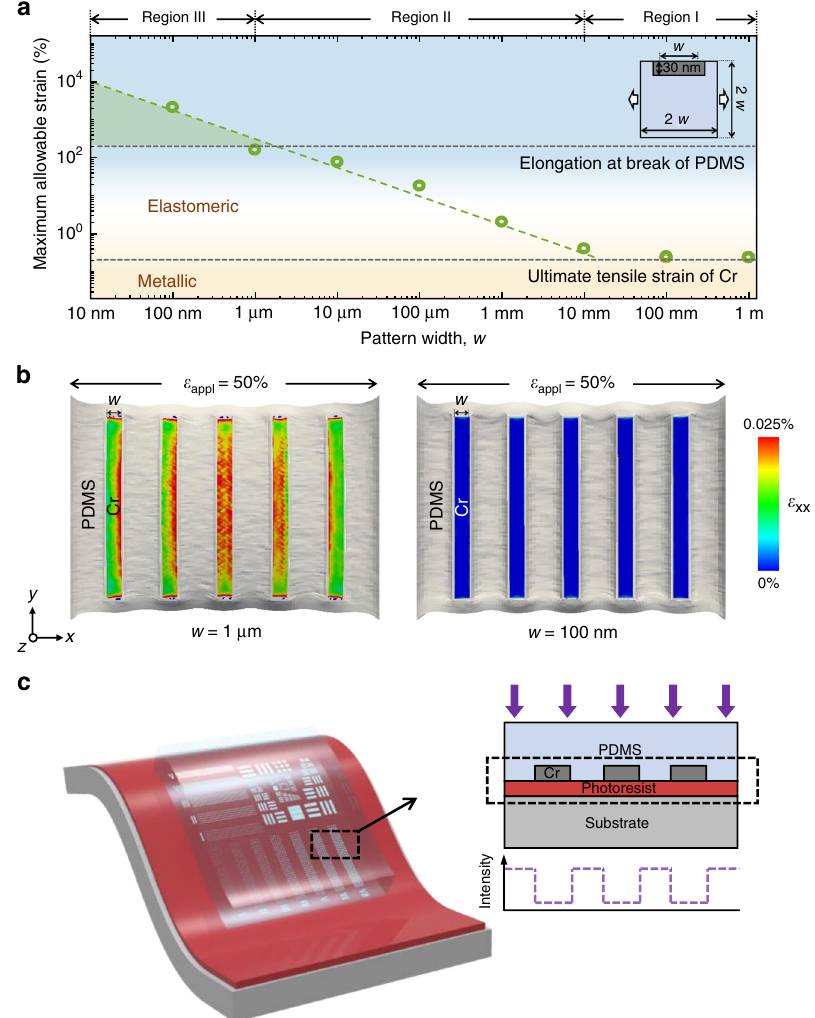
Fig. 1 Concept of optical contact lithography technique using a metal-embedded elastomeric photomask. a Numerical simulation results (dots) of the maximum allowable strain of a metal pattern embedded in an elastomeric substrate at different metal pattern widths ( w ). The dashed line shows a fi tted line of simulation results. The inset shows schematic illustration of model for simulation model. b Simulated results of strain ( ε xx ) distribution in a Cr line array pattern embedded in a PDMS substrate for w = 1 µ m (left) and w = 100 nm (right). c Schematic illustration of contact printing with a soft photomask (left) and light intensity pro fi le